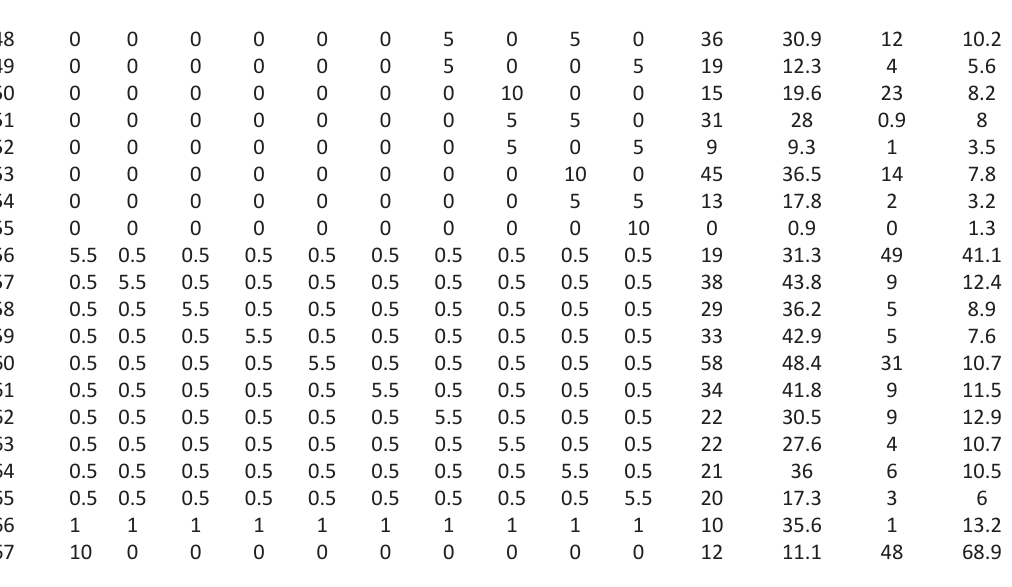
Table 2. Analysis of variance (ANOVA) of undecylprodigiosin production based on mixture design